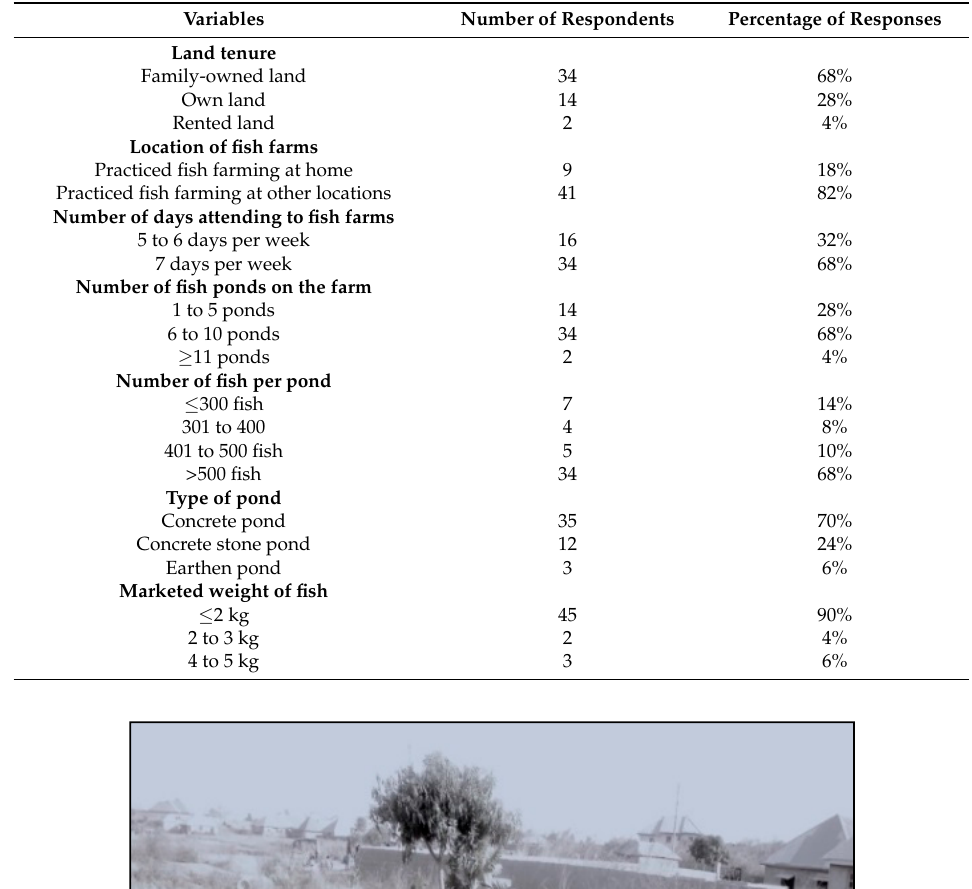
Table 2. Fish farming practices and characteristics in Jos.